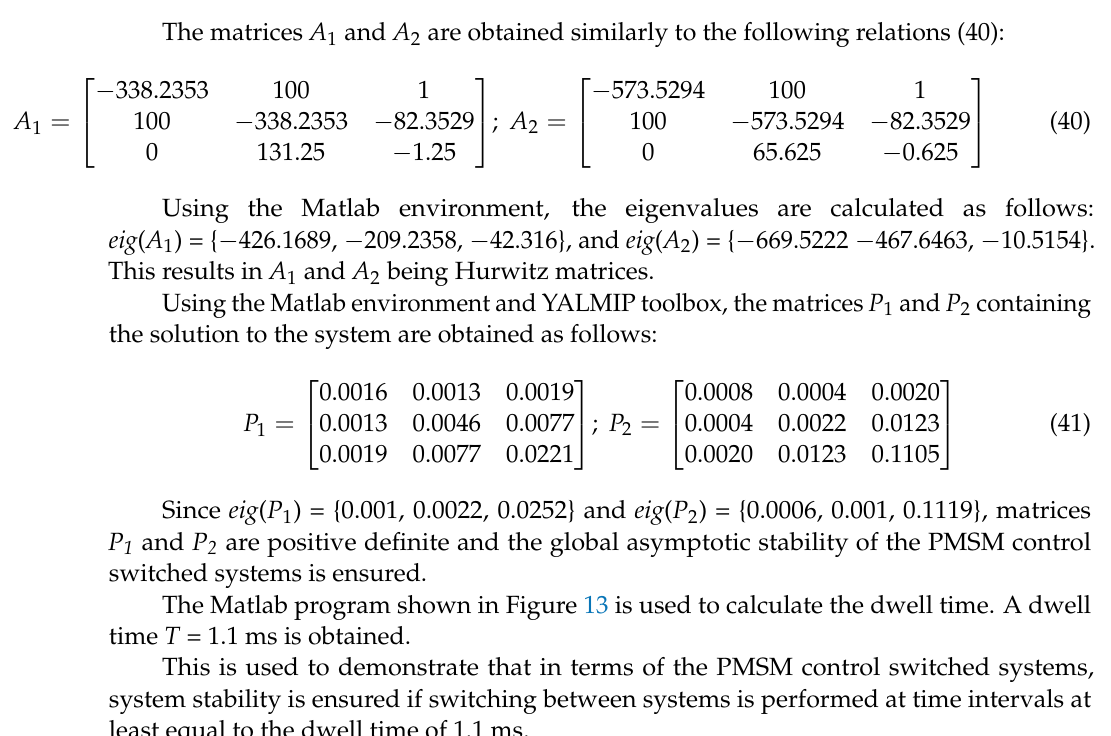
Figure 12. Matlab program for matrices A i and P i determination—variable structure 1.